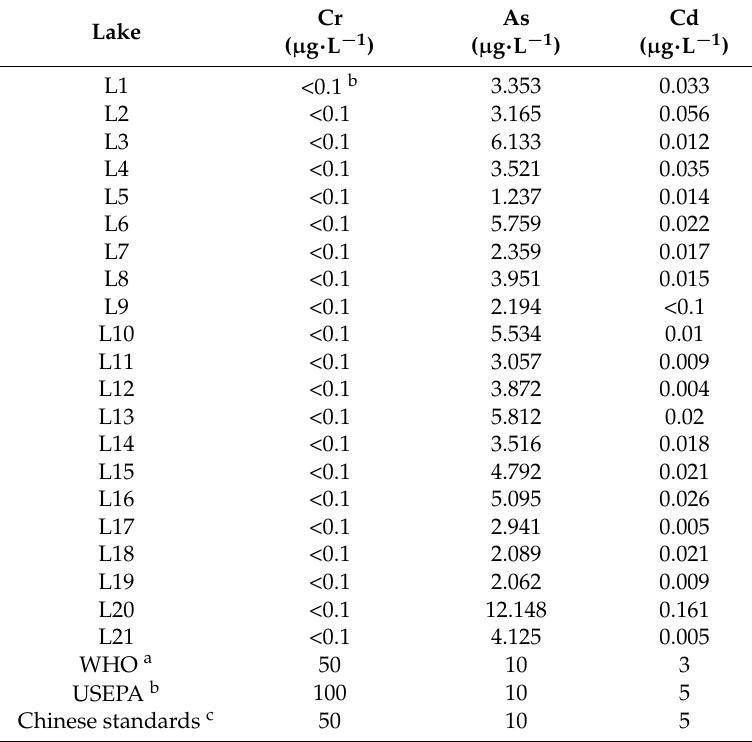
Table 4. The concentrations of heavy metals in 21 lakes in